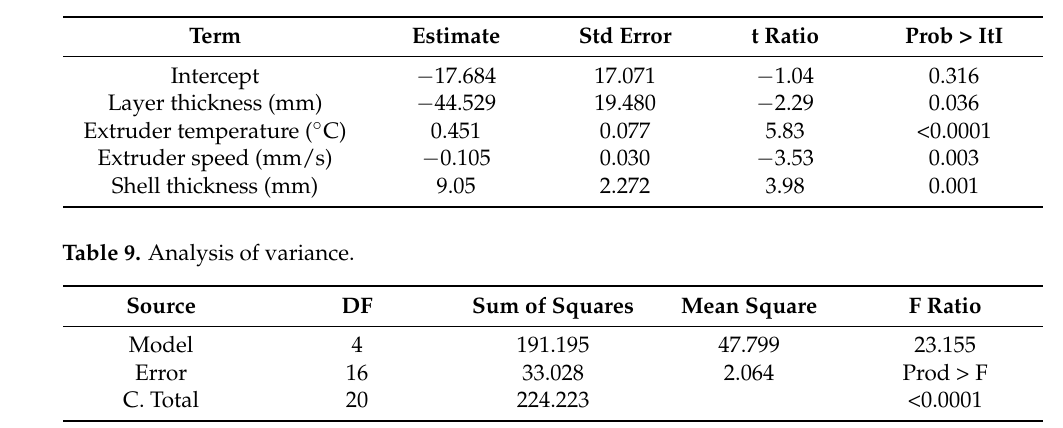
Table 8. Parameter estimates.